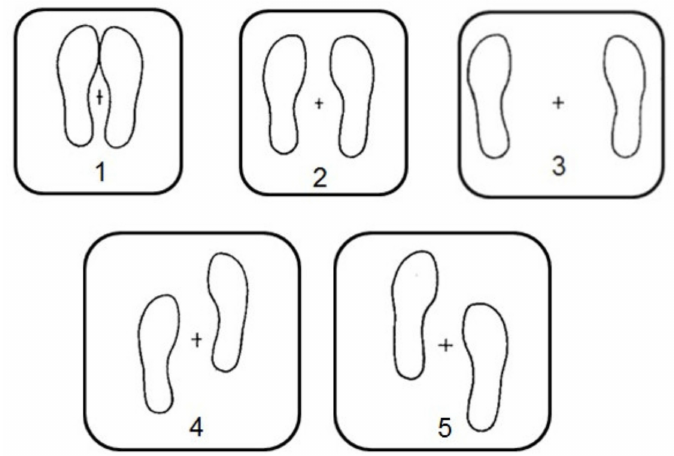
Figure 1. Positions used in the current experiments. ( 1 ) feet together; ( 2 ) feet 15 cm apart; ( 3 ) feet 30 cm apart; ( 4 ) right foot forward 10 cm; ( 5 ) left foot forward 10 cm (cfr. Coco et al.,